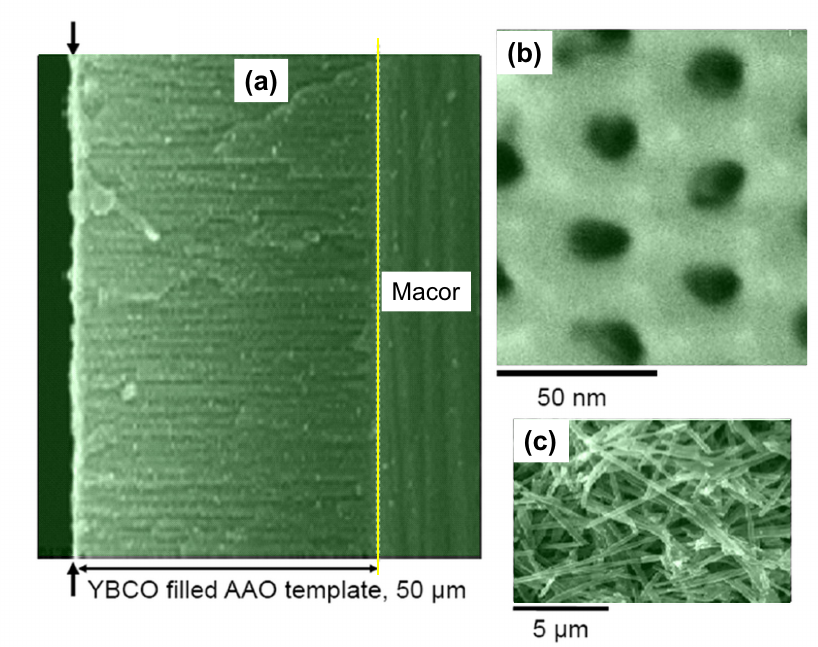
Figure 8. ( a ) SEM cross-sectional view of a YBCO-filled, commercial Whatman anodisc AAO [37] template. For easier handling in the experimetal procedures, the AAO template was glued onto a Macor™ ceramic plate. The arrows mark the still remaining top layer of YBCO material, and the yellow line indicates the template bottom. ( b ) SEM top surface view of the filled template. The YBCO material appears dark; ( c ) shows extracted YBCO nanowires from the templates after NaOH etching. The length of the extracted nanowires is ranging between 2 and 10 µ m, but the nanowire surfaces have many structural defects.